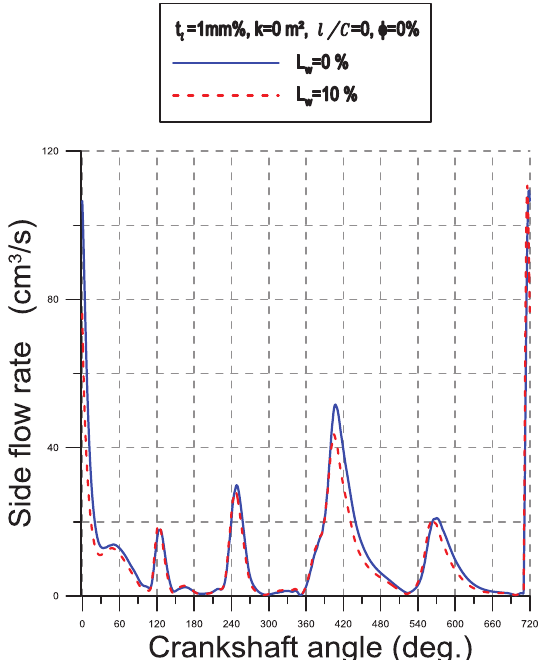
Fig. 11. Effects of dynamic misalignment on side leakage fl ow over an entire cycle.